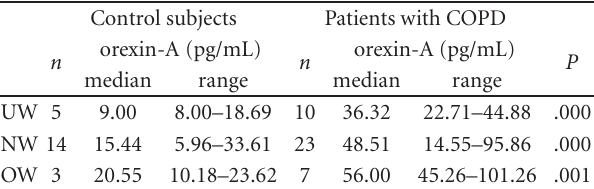
Table 2: Plasma orexin-A levels in weight-based